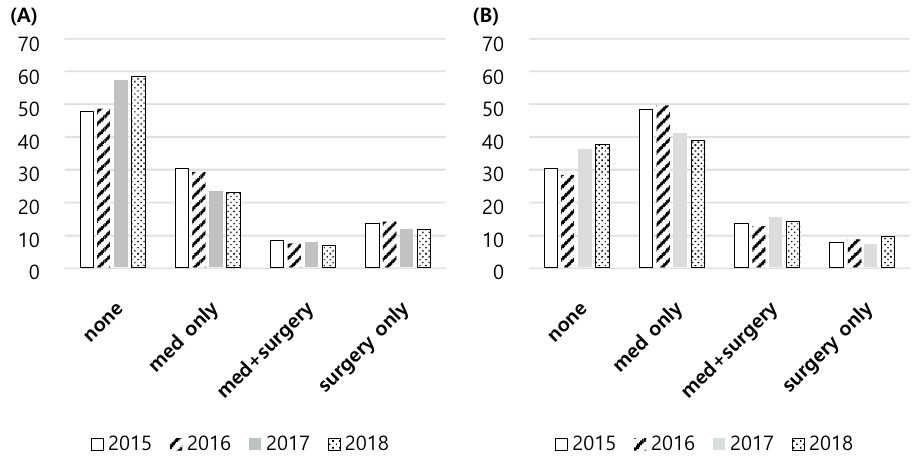
Figure 2. PDA treatment strategy by year among the ( A ) neonate and ( B ) VLBW infants in Korea.